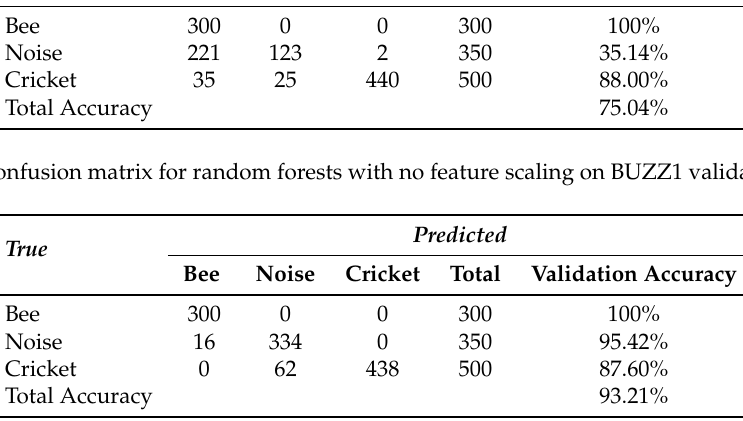
Table A10. Confusion matrix for KNN with n = 5 and no feature scaling on BUZZ1 validation dataset.